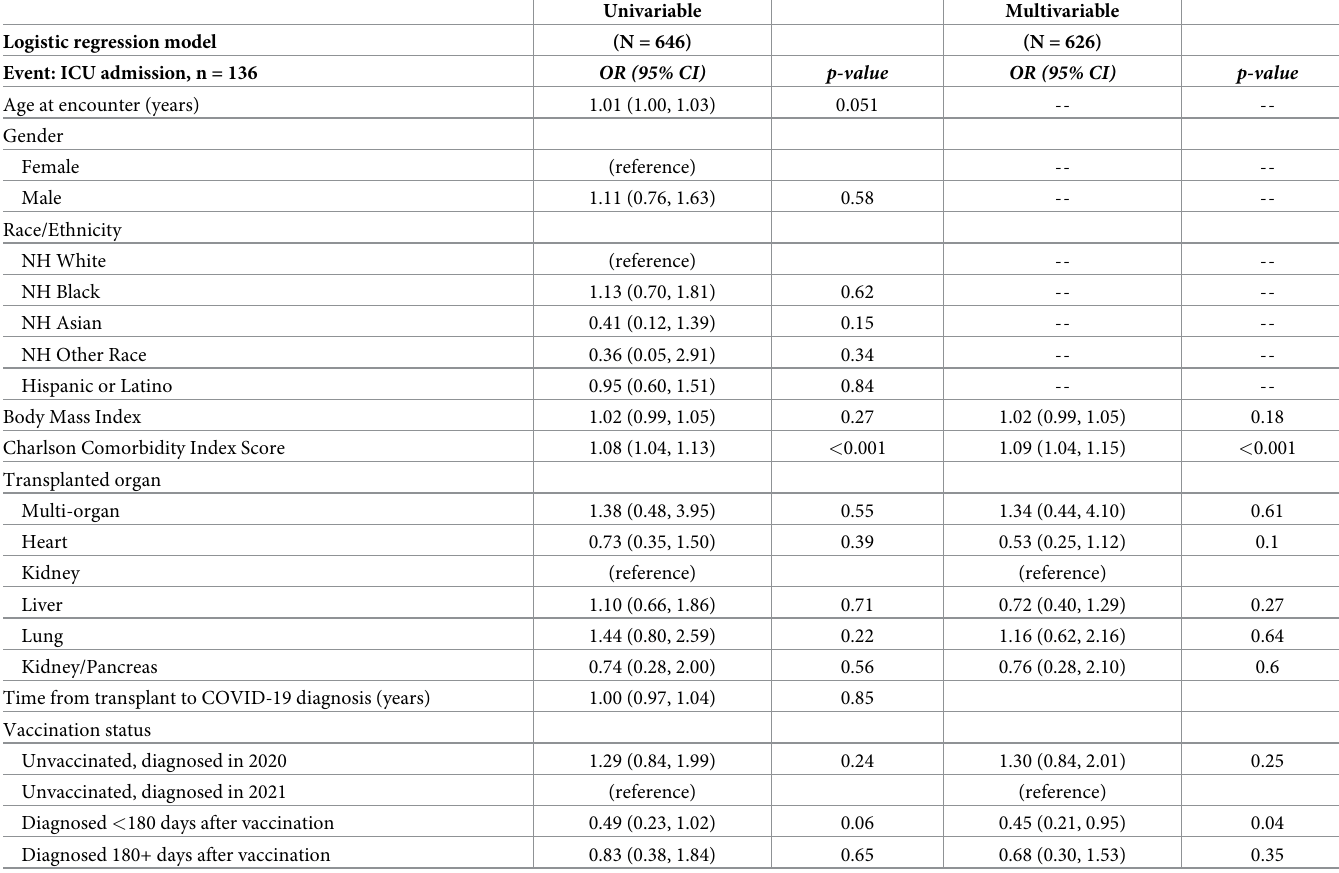
Table 3. Risk of ICU admission among solid organ transplant recipients diagnosed with